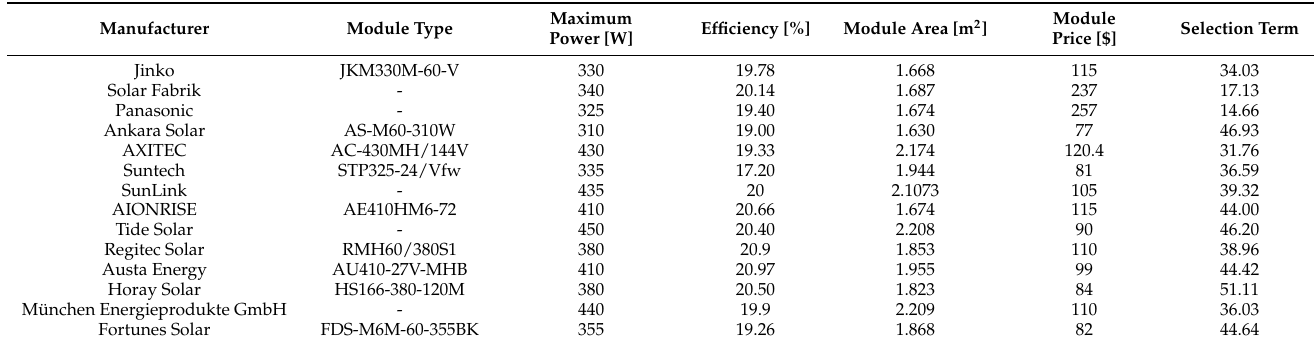
Table 2. Selection criteria ratio for PV modules.